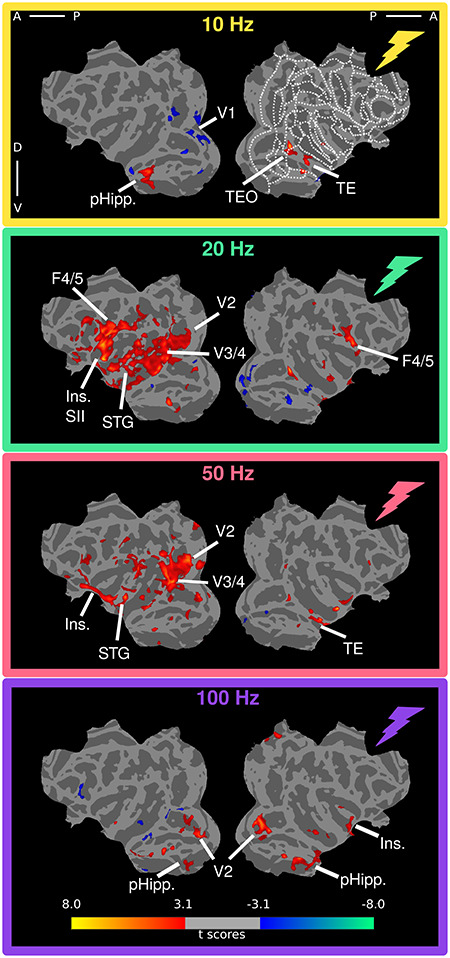
fMRI responses to VTA stimulation across frequencies in awake monkeys. T-score maps of the stimulation frequency versus baseline (uncorrected level, P < 0.001; cluster correction, 20) overlaid onto cortical flatmaps in the D99 template space (see methods). Regions showing significant activation are indicated on the maps. For a complete overview of ROIs and ROI abbreviations in D99 space see Supplementary Material S5.